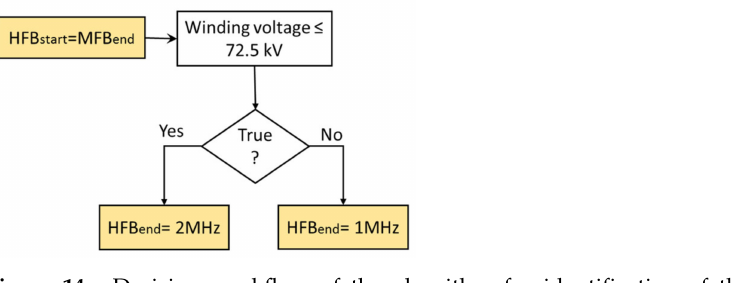
Figure 14. Decision workflow of the algorithm for identification of the high-frequency sub- band (HFB end